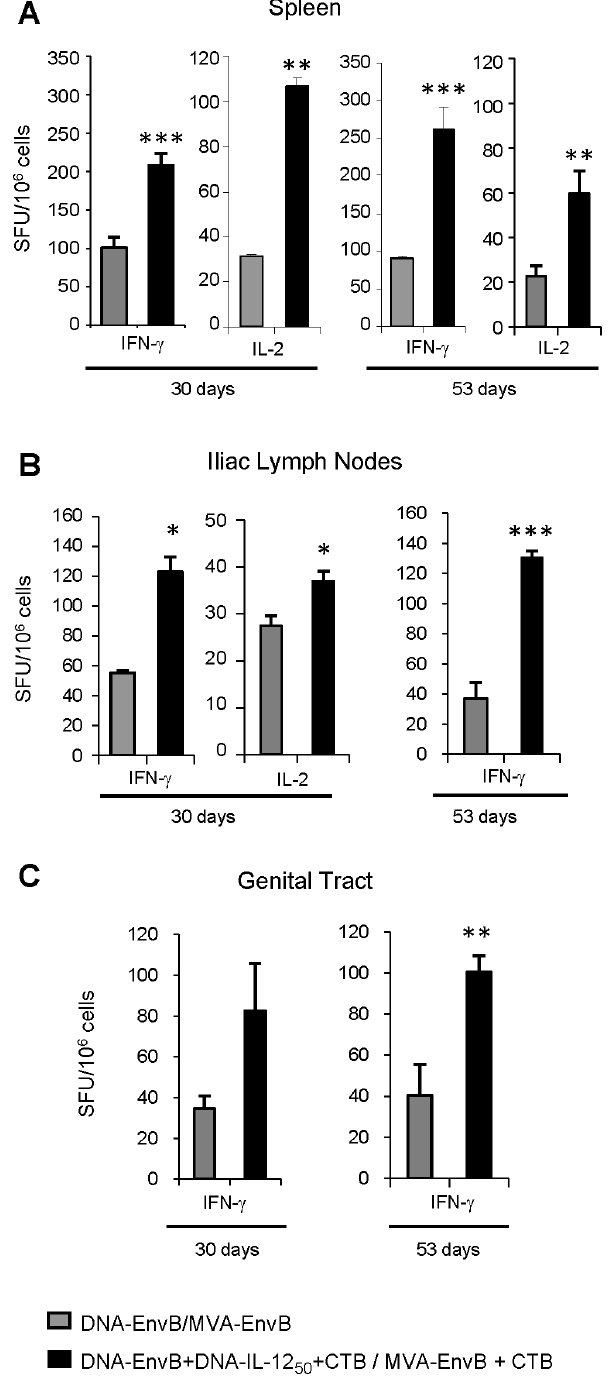
Figure 3. T-cell response improvements afforded by DNA-IL-12 plus CTB administration during DNA/MVA immunizations were maintained during the memory phase of the adaptive response. Thirty or 53 days post- immunization, Env specific IFN c and IL-2 secreting T-cells were evaluated by ELISPOT using pooled cells from six mice in (A) spleen, (B) iliac lymph nodes (ILNs) and (C) genital tract for DNA-EnvB/MVA-EnvB control group (grey bars), and DNA- EnvB + DNA-IL-12 50 + CTB/MVA-EnvB + CTB group (black bars). Bars repre- sent the average of spot forming units (SFU)/10 6 cells + SD for duplicate or triplicate wells. Background values of negative control wells were subtracted. Data are representative of three (30 days) and two (53